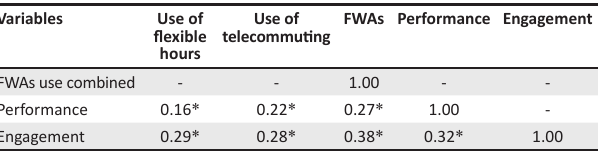
TABLE 4: Pearson’s correlation